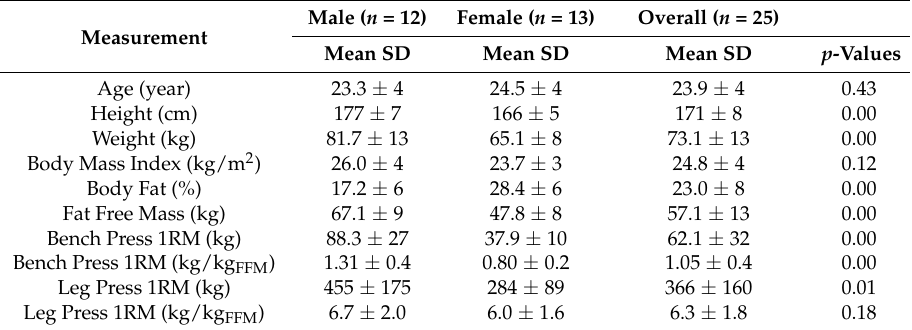
Table 1. Baseline